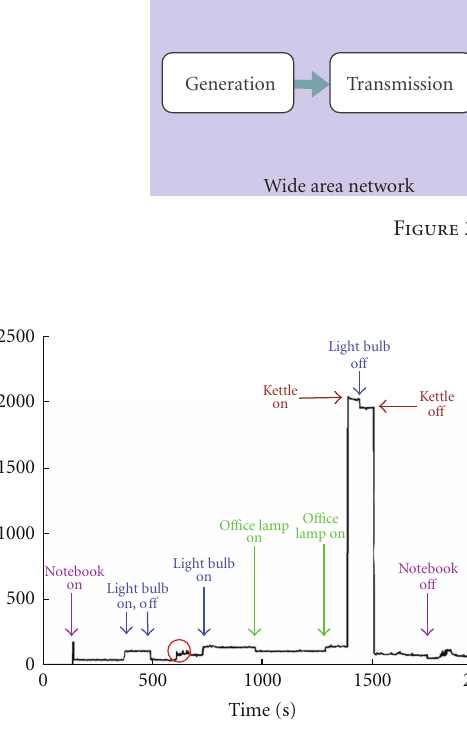
Figure 4: House electricity demand and information extracted: apparent power (Volt ∗ Ampere) for notebook, lighting sources, and a kettle [29]. Table 2: HAN standards and security algorithm, main characteris-